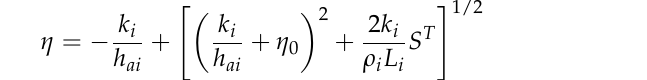
Table 1. Results of ice thickness calculations on the Łapino reservoir in